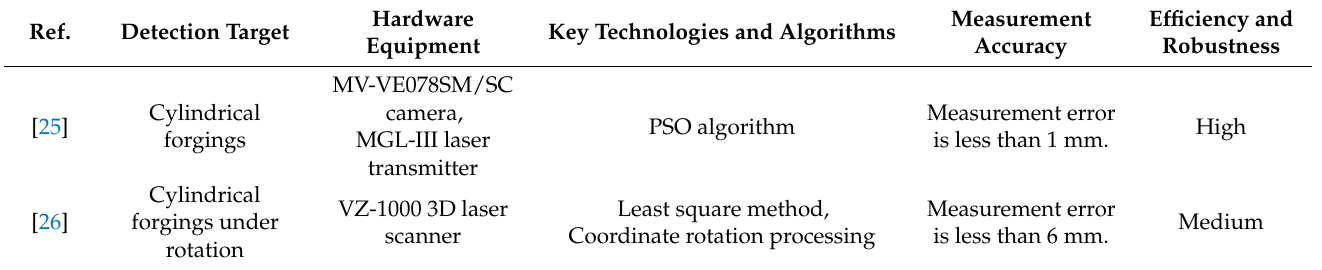
Table 2. Comparison of measurement quality of laser